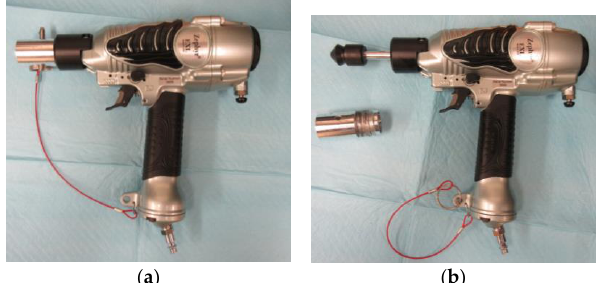
Figure 1. The non-penetrating captive bolt device (Zephyr-EXL) with safety pin inserted ( a ) and